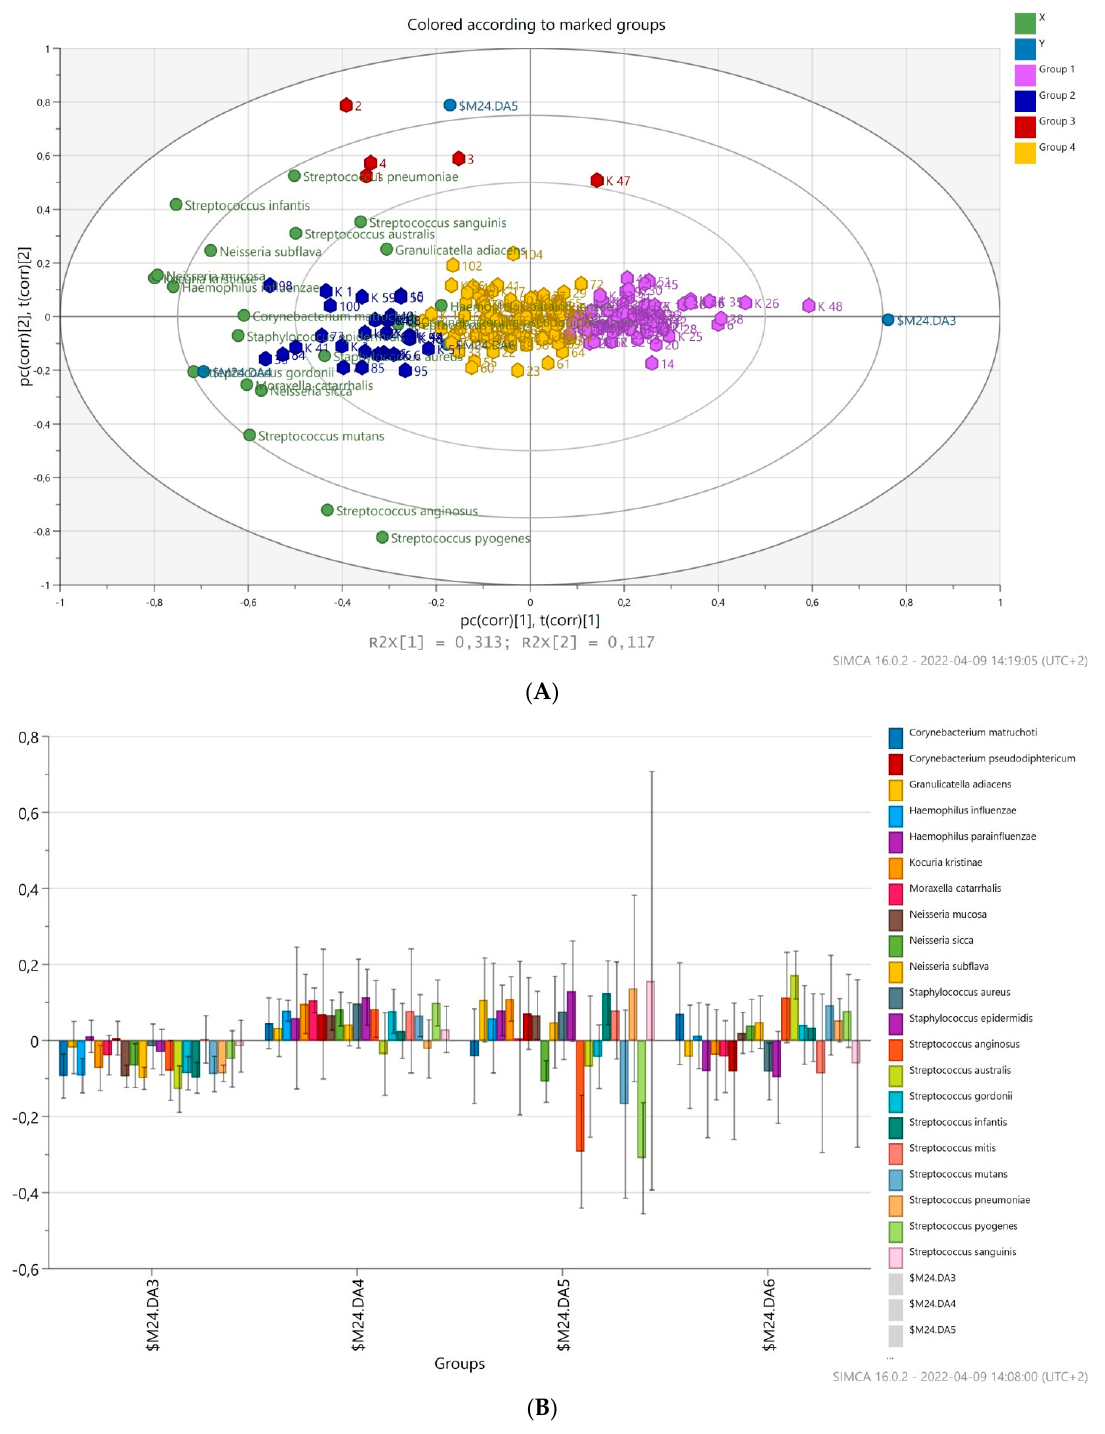
Figure 5. PLS-DA with nasopharyngeal samples was performed based on the 21 bacterial species tested. ( A ) Biplot of PLS-DA with nasopharyngeal samples. Different colors of points in plots were represented for different groups. ( B ) Coefficient overview plot displays how bacterial species take part in four created groups: M17DA3, violet; M17DA4, blue; M17DA5, red; M17DA6, yellow.